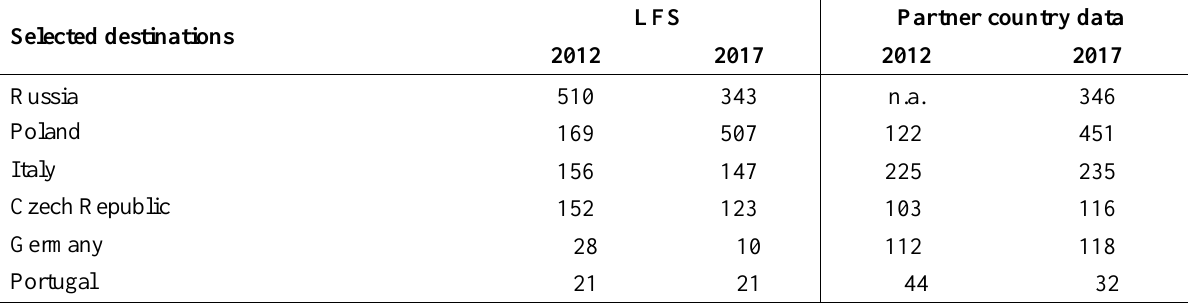
Table 3. Estimating the numbers of migrants by data from different surveys Selected